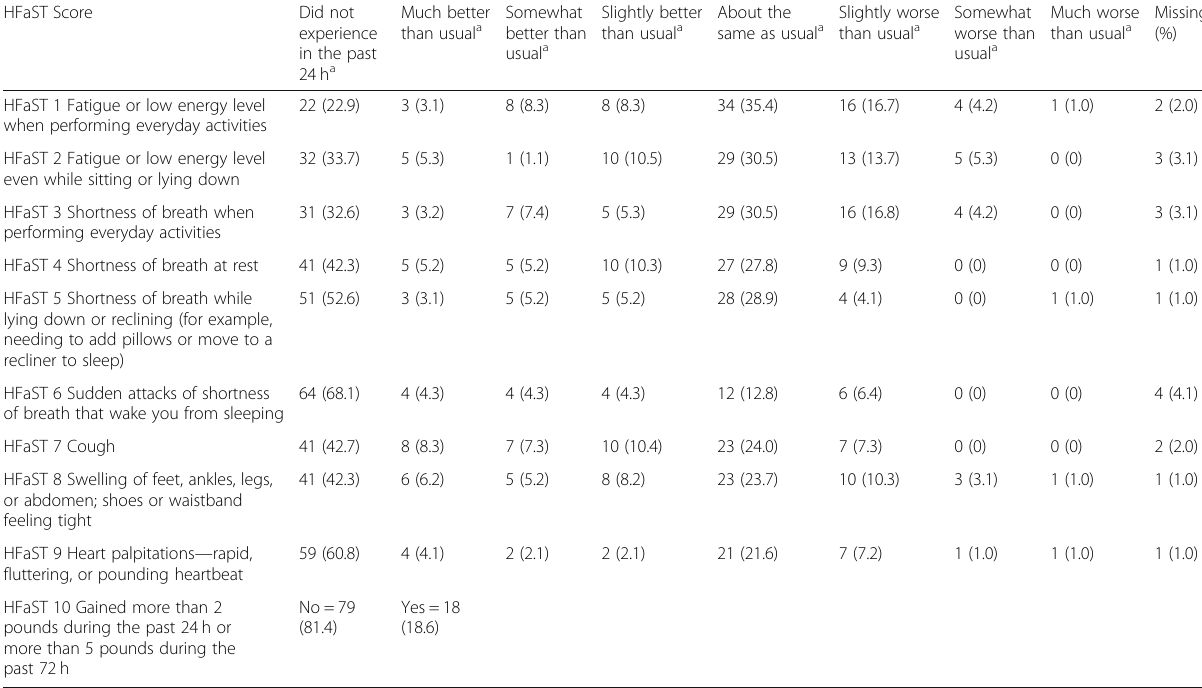
Table 1 HFaST Item-level Response Distributions for Study Day 4 HFaST